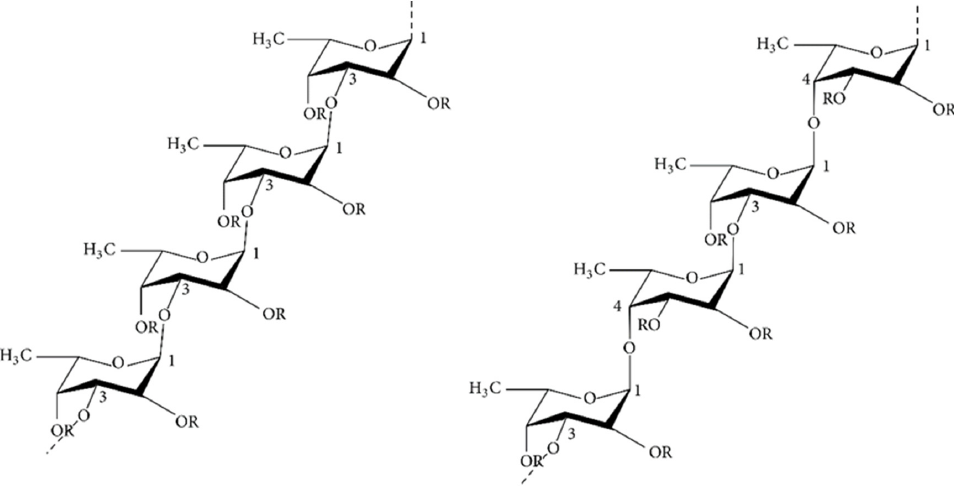
Figure 3. Chemical structures of two different backbones for fucoidan [55].